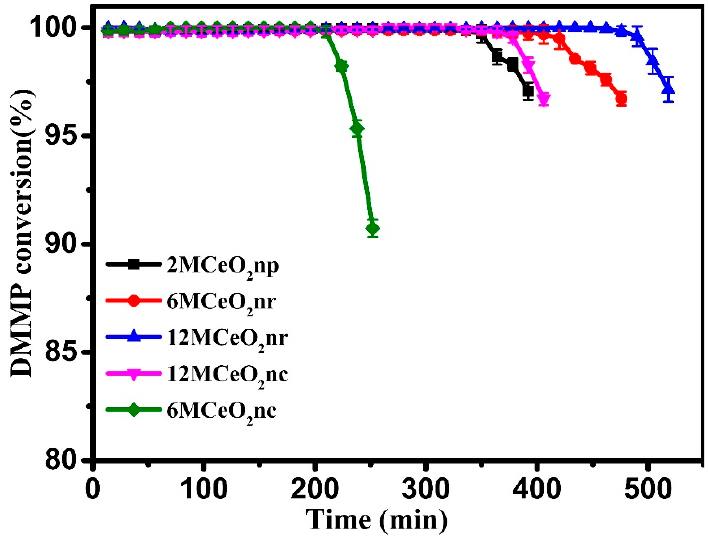
Figure 7. Effects of morphology and size various CeO 2 on protection time with the following conditions: Reaction temperature, 300 °C; DMMP concentration, 5.32 g/m 3 ; GHSV, 10,000 h − 1 ; catalyst weight, 0.66 g CeO 2 nanocubes, 0.42 g CeO 2 irregular nanoparticles, and 0.42 g CeO 2 nanorods; size, 20–40 mesh.